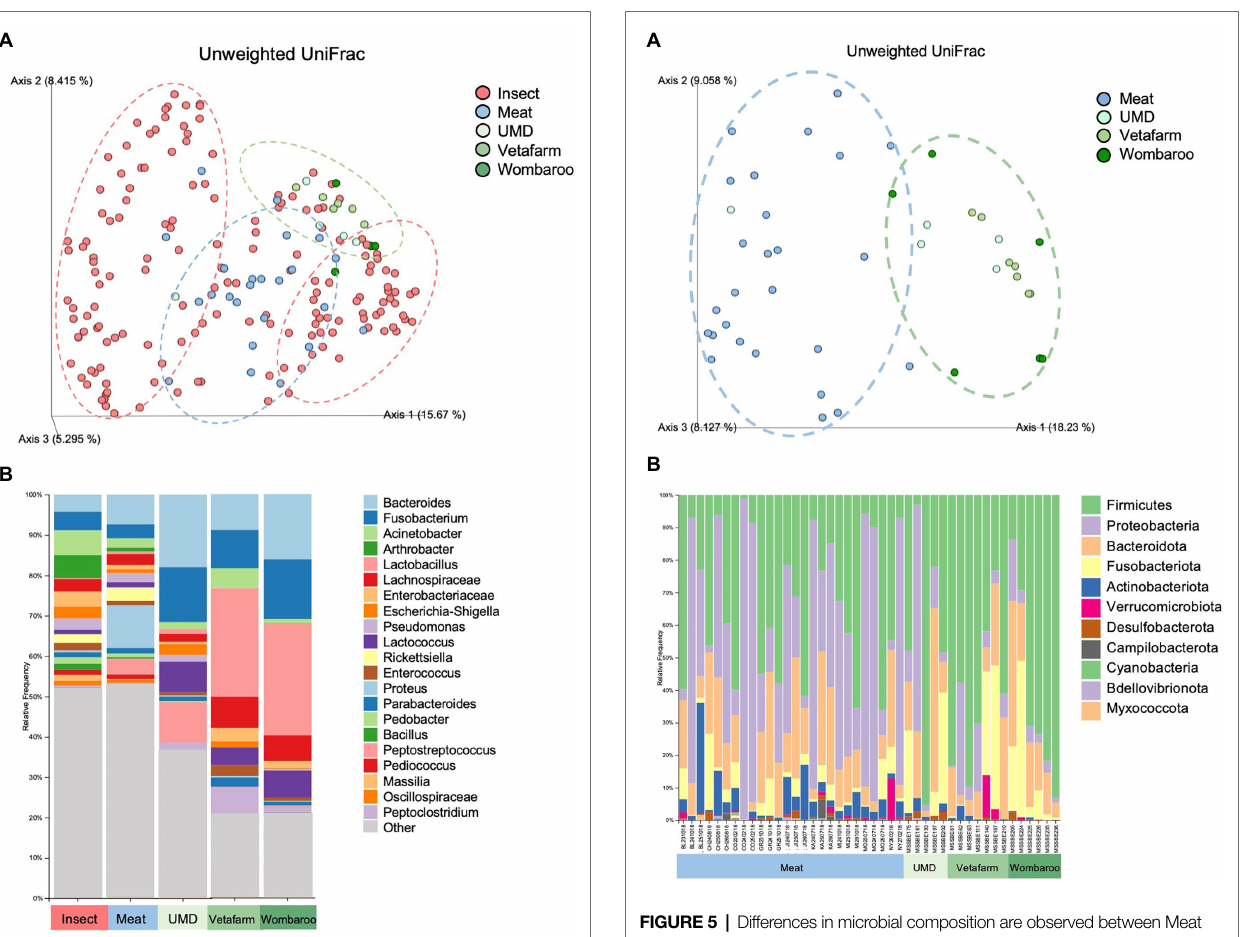
FIGURE 4 | Differences in microbial composition are observed between samples collected in wild compared to samples collected in captivity from echidnas fed four different diets. (A) PCoA plot of unweighted UniFrac distances showing clustering patterns of wild samples (insect diet) and zoo samples (Meat, UMD, Vetafarm and Wombaroo diets). Green dotted circle shows the Taronga Zoo samples mostly clustering together; Blue dotted circle shows the Perth Zoo samples mostly clustering together between the two major clusters of the Wild samples within the red dotted circles. (B) Taxonomy bar plots showing relative frequencies of bacteria present in echidna scats shown at the genus or family level; all samples have been aggregated according to their diet, and an average relative frequency is shown. Samples are labelled by their diet where insect refers to wild collected samples. UMD, Updated Meat Diet. Original and interactive QZV files to view bar plots are available in Supplementary Files .